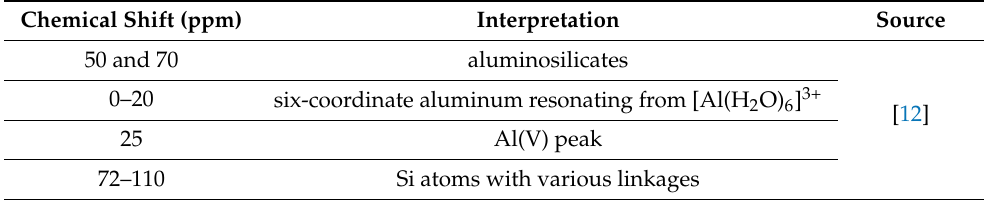
Table 2. Chemical shifts of vacuum dehydrated geopolymers observed through 27 Al and 29 Si NMR. Chemical Shift